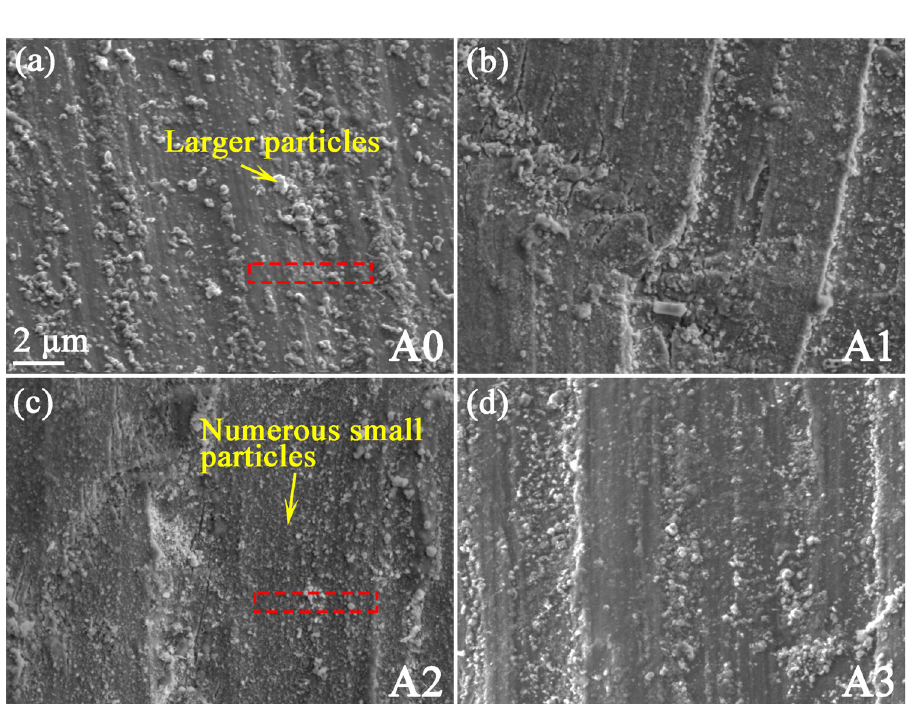
Fig. 4 Surface oxide fi lms near the fractures. a A0 sample (0Al – 0.6Nb), b A1 sample (2.5Al – 0.6Nb), c A2 sample (3.5Al – 0.6Nb), d A3 sample (3.5Al –